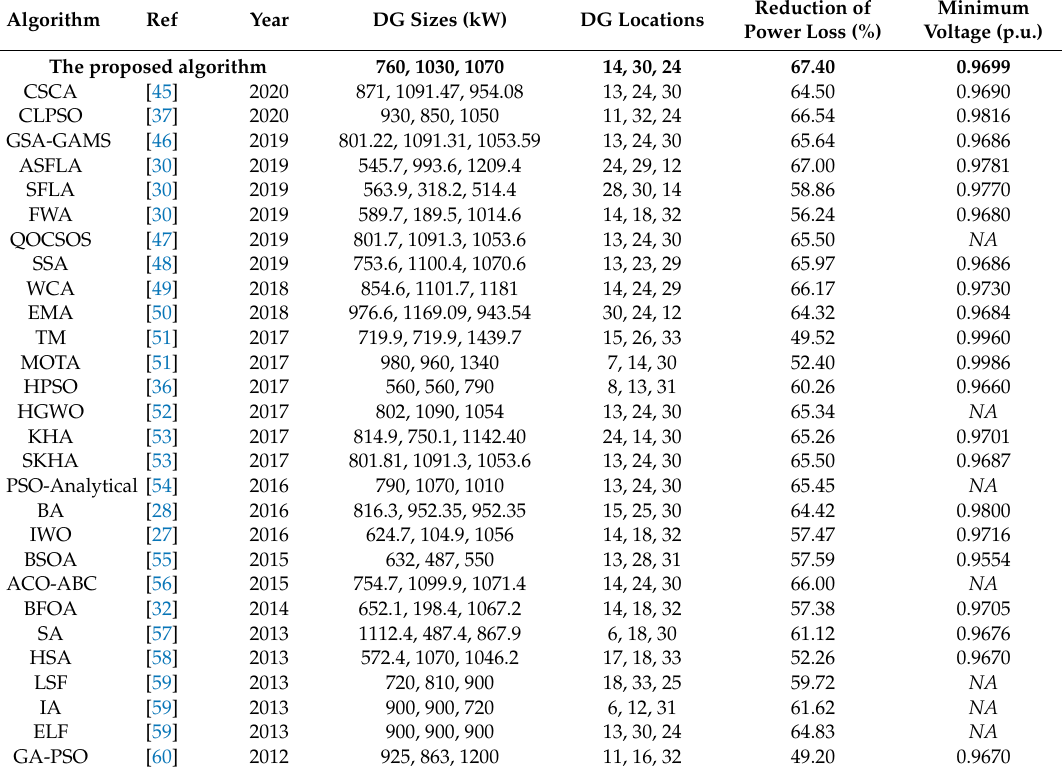
Table 7. Comparison of results of the standard IEEE 33 bus